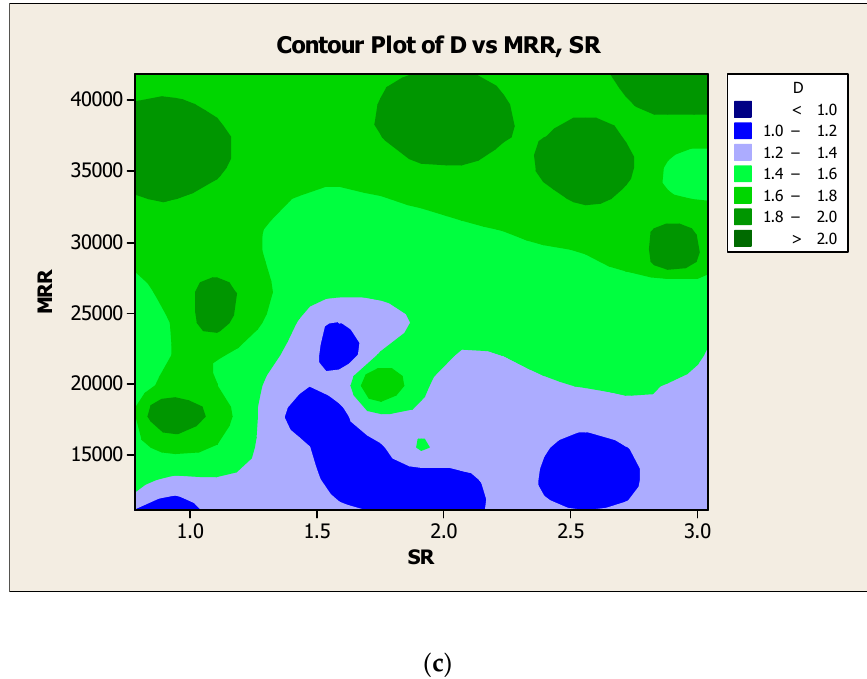
Figure 21. Contour diagrams with respect to MRR and SR for ( a ) N, ( b ) F, and ( c ) D. Figure 22 shows a graphical representation of the experimentally measured results of the material removal rate (MRR) in mm 3 /min (Y-axis) for each specimen from 1 to 27 (X-axis). In this aspect, MRR fluctuated from maximum to minimum and vice versa. At last, the maximum MRR was obtained for the 27 th specimen, and the minimum MRR was obtained by the first specimen. Figure 23 plots the experimentally measured results of surface roughness in µm (Y-axis) for the entire specimen considered from 1 to 27 (X-axis). SR had heavy fluctuations as per the results as evident by the sine waves. In addition, maximum and minimum values were reached in between successive results. Similarly, Figure 24 was plotted to demonstrate the cutting force in N (Y-axis) for each specimen from 1 to 27 (X-axis).